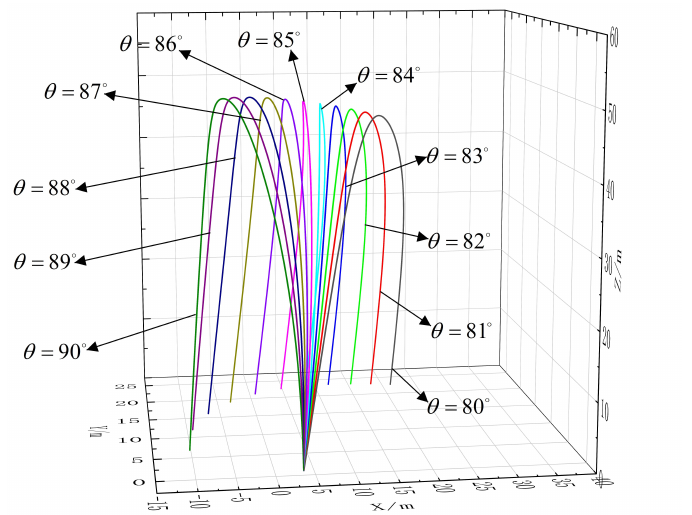
Figure 7. Simulation of the 3D jet trajectory of a water cannon under constant horizontal wind